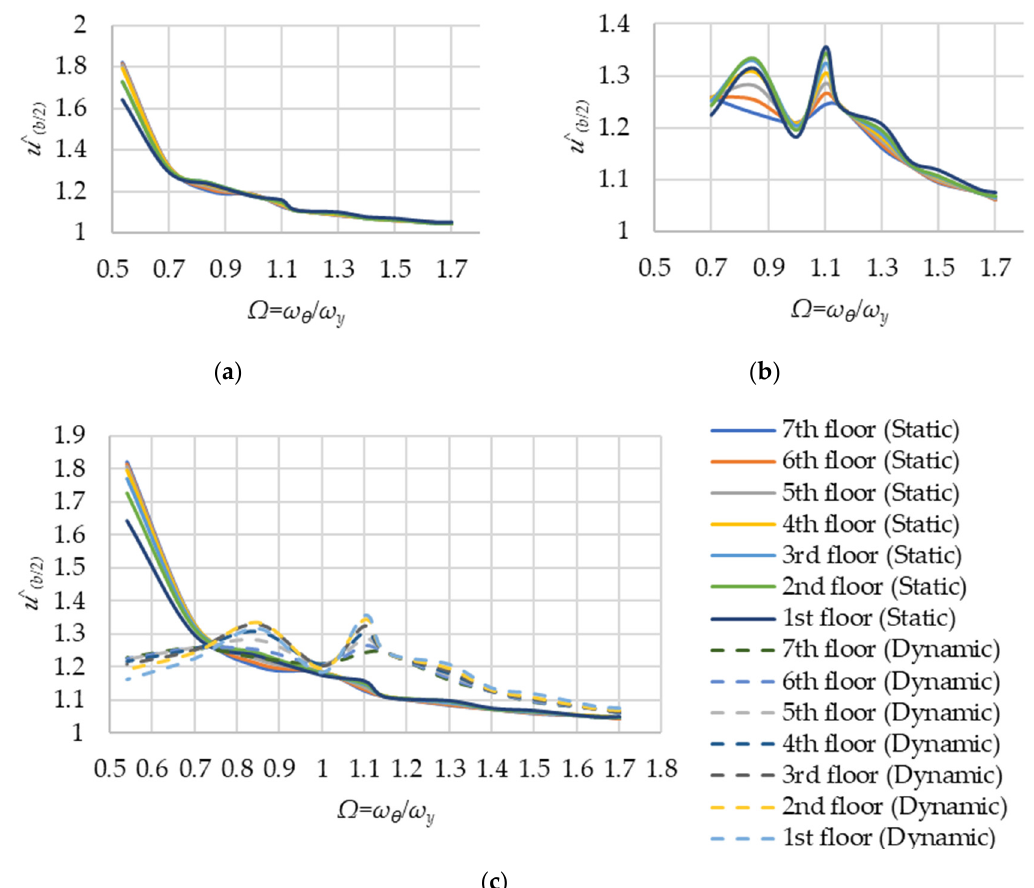
Figure 11. Normalized flexible edge displacement (with b / r = 2.45, Ty < 1 s): ( a ) Static edge displacement; ( b ) Dynamic edge displacement; ( c ) Static vs. dynamic edge displacement.